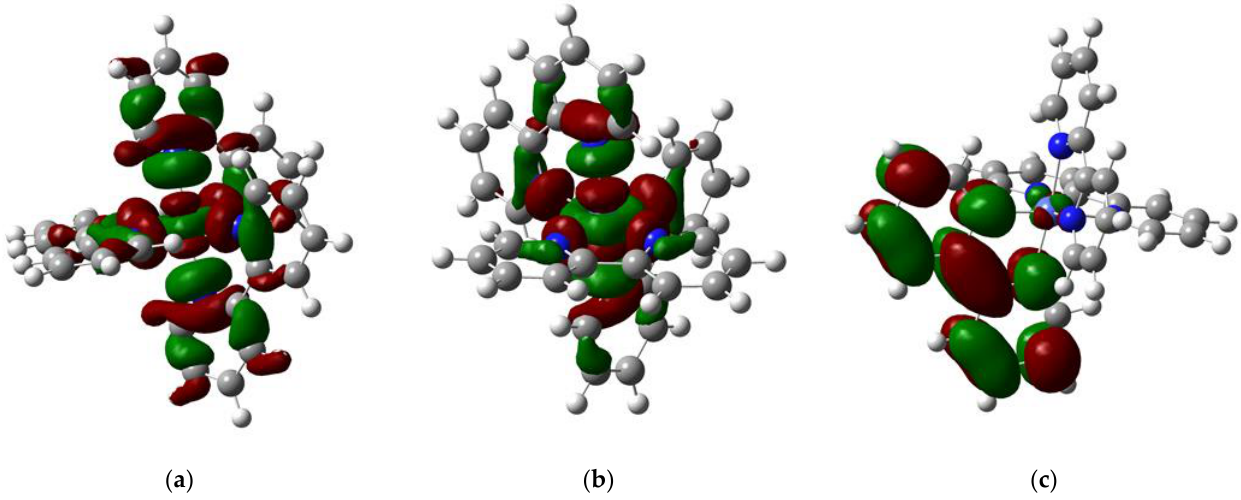
Figure 13. SOMO diagrams of the species ( a ) [Co II (bipy) 3 ] 2+ , ( b ) [Co I (bipy) 3 ] + , and ( c ) [Co I (bipy)(bipy − ) 2 ] − .